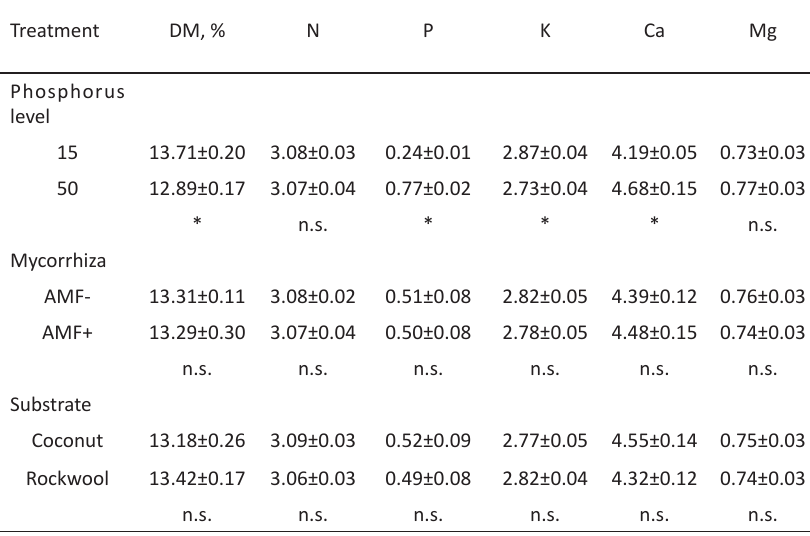
Table 5. Effect of phosphorus level in the nutrient solution (mg dm -3 ), mycorrhiza and type